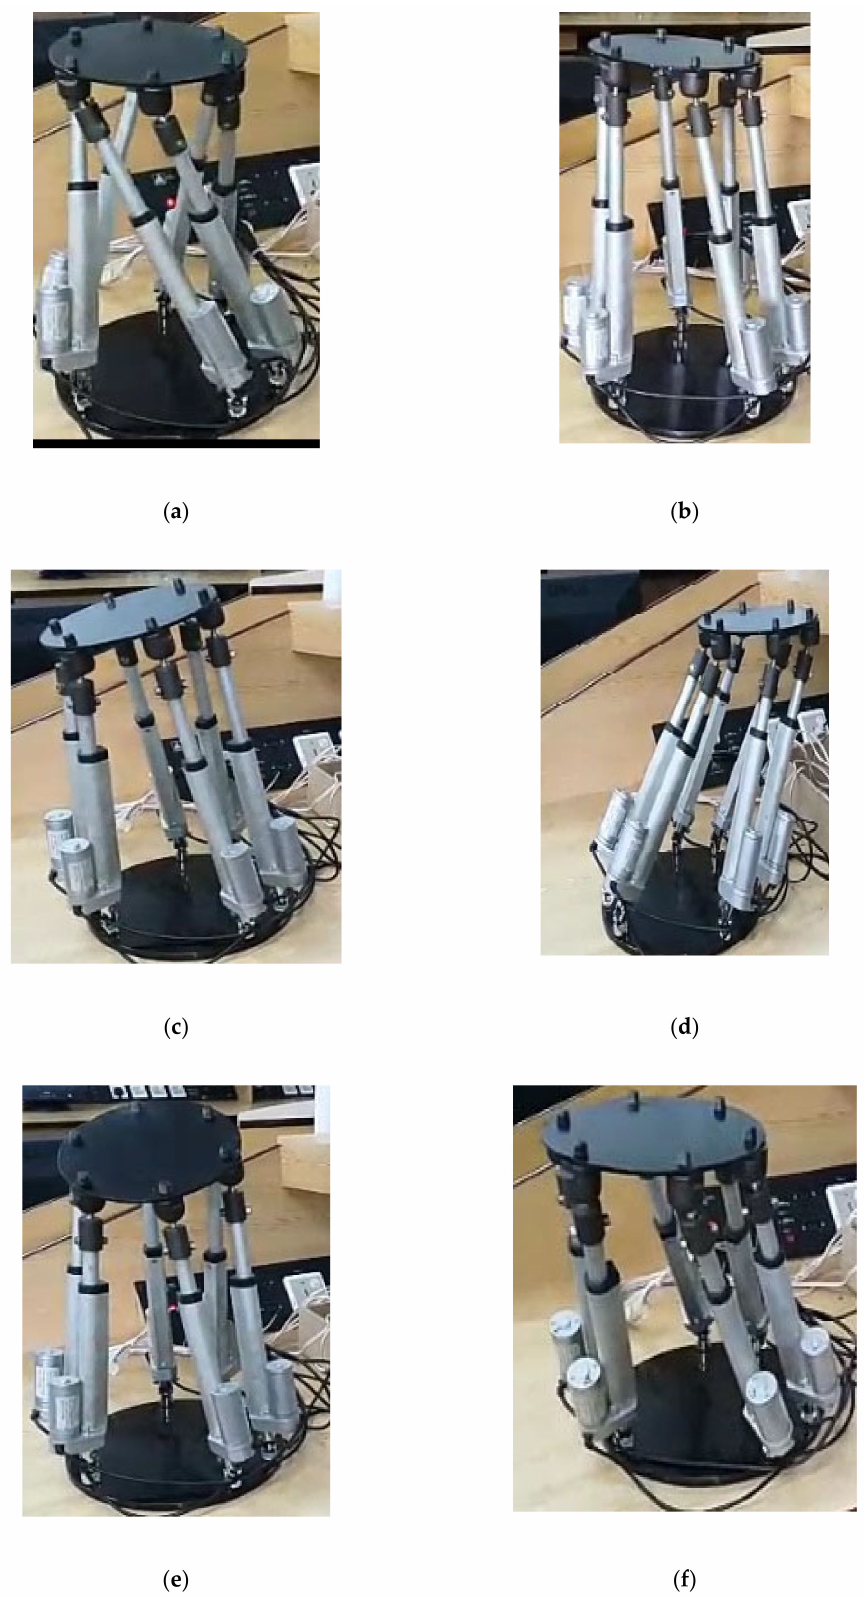
Figure 15. ( a ) Rotation in Z-Axis, ( b ) Translation in Z-Axis, ( c ) Rotation in Y-Axis, ( d ) Translation in Y- Axis, ( e ) Rotation in X-Axis, ( f ) Translation in